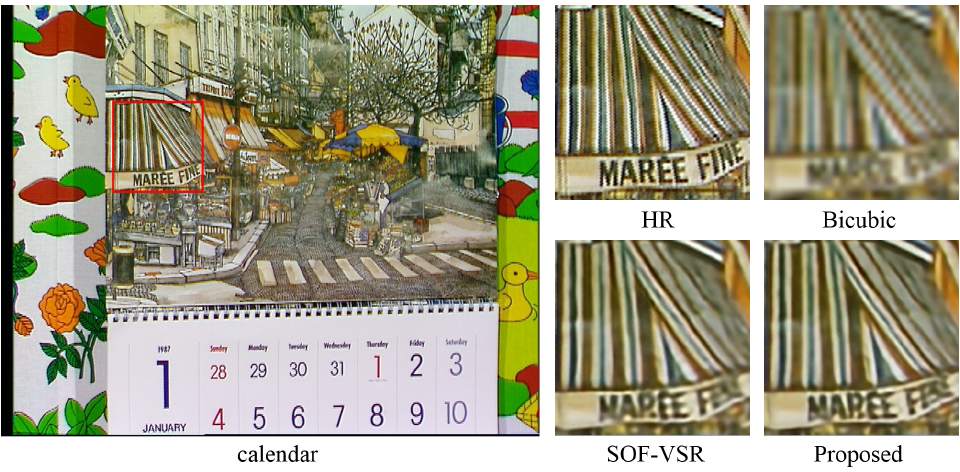
Figure 1. Results of different reconstruction methods by × 4 scale on calendar video